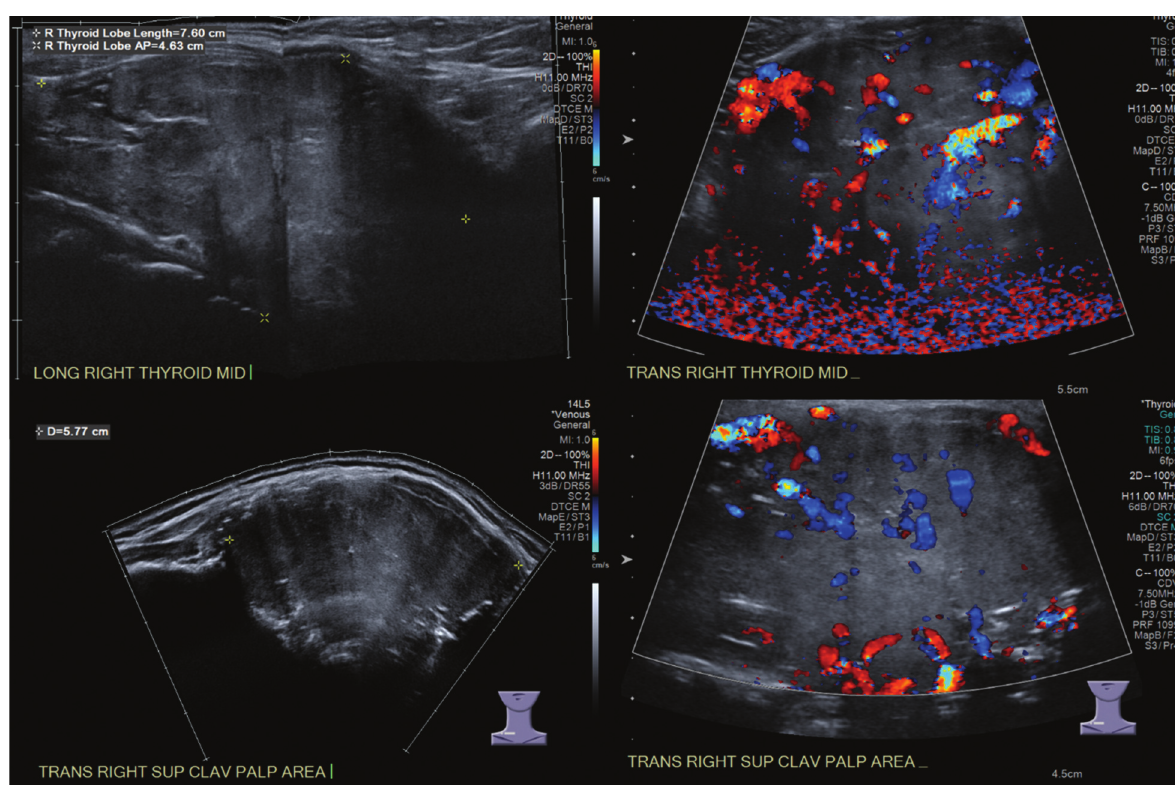
Figure 1: Ultrasound image demonstrating a diffuse mildly heterogeneous enlargement of the right thyroid lobe (a). The associated increased flow within the right thyroid lobe on the color Doppler image (b). A soft tissue mass also seen in the region of palpable concern in the right supraclavicular area, measuring 5.77cm (c). The associated internal flow in the mass on the color Doppler image (d).